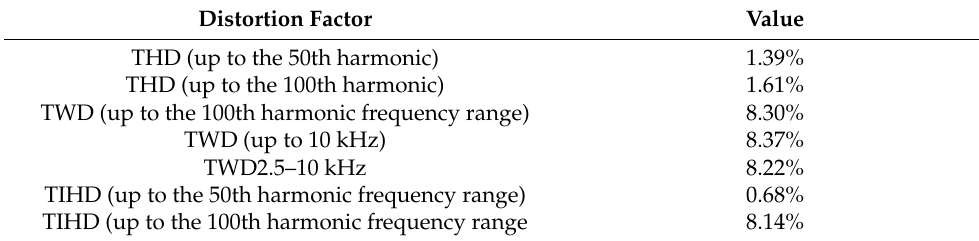
Table 3. Distortion indices calculated for the example from Figure 4. Distortion Factor Value THD (up to the 50th harmonic) 1.39% THD (up to the 100th harmonic) 1.61% TWD (up to the 100th harmonic frequency range) TIHD (up to the 50th harmonic frequency